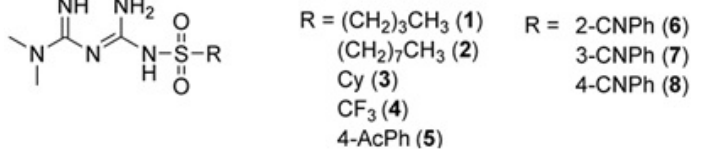
Figure 1. Structure of examined biguanides. Explanatory notes: Ac—acetyl, CN—cyano, Cy—cyclohexyl, Ph—phenyl.